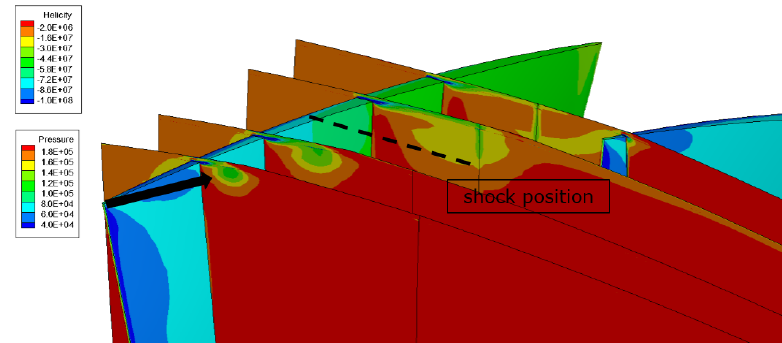
Figure 17. Helicity distribution on crossflow planes at NS (with blade surface colored by static